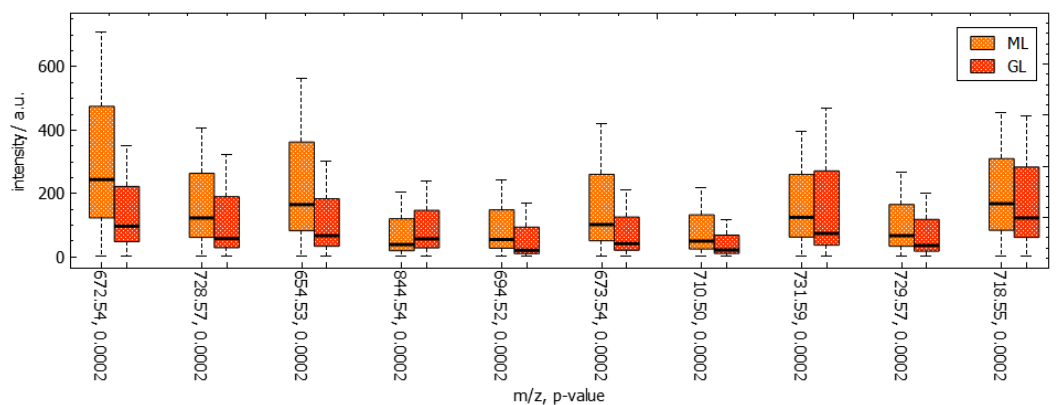
Figure 14. Juxtaposed boxplot visualization allows for quantitative comparative analyses of peak intensity distributions between regions for selected discriminant peaks according to Figure 13. Here, the granular layer (GL) and molecular layer (ML) have been selected for comparison (cf. Figure 12).